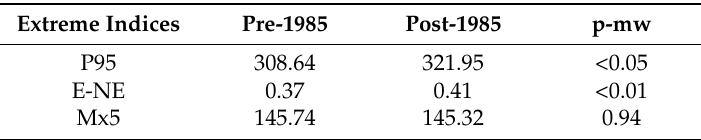
Table 3. Statistical difference tests in the mean in the extreme rainfall indices (P95/mm, E–NE (fraction) and MX5/mm) between pre-1985 and post-1985 periods.